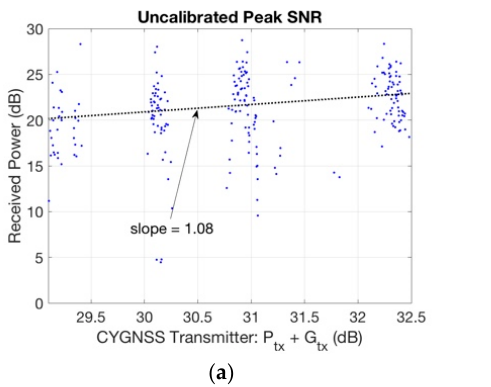
Figure 15. Impact of the direct signal power and gain differences between GPS satellites for February 2018 data. Up to 4 dB total difference correction is observed from minimum to maximum values, which applies to both H-pol and V-pol.